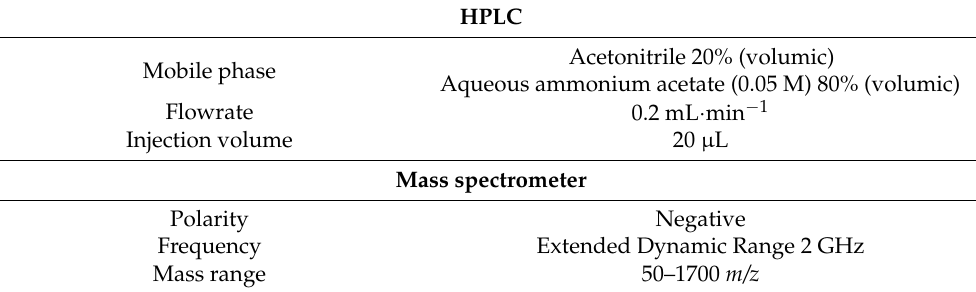
Figure 8. ( a ) UV-visible photodegradation results of AR14 by ZnO NWs (grown conditions (1), 4 h, 90 °C) under UV light and ( b ) comparison of the AR14 degradation results depending on the analytic method (UV light: ~365 nm, I received by the sample = 35 mW/cm²). Table 1. HPLC-MS parameters of the analysis of AR14.